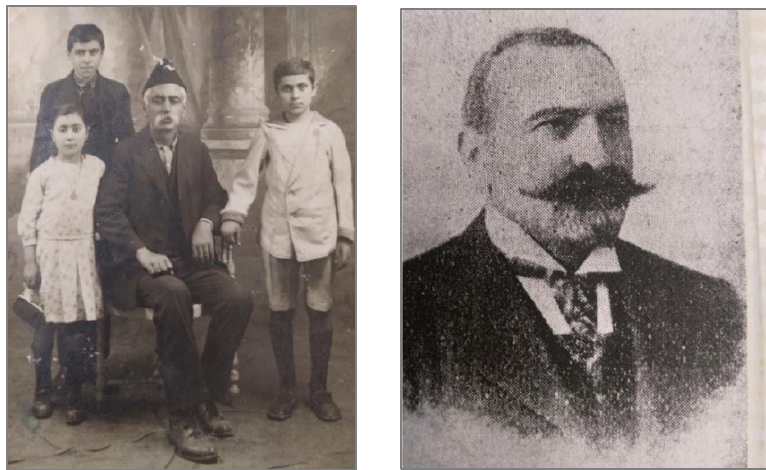
Figure 5, 6 Photos of family members living in Karaman Mansion (figure 5ArtinAgha Karamanian sitting His daughter Mary and son Garbis standing next to him. Kapriel standing in the back. Figure 6 Loghvet Baliozyan (1851-1899), was